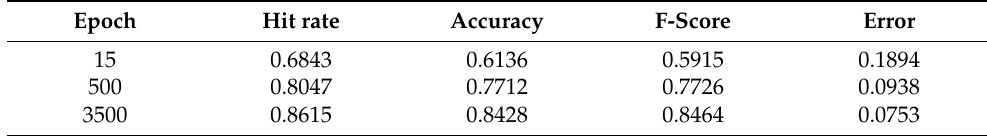
Table 4. Evaluation of the CloudSegNet in different epochs.